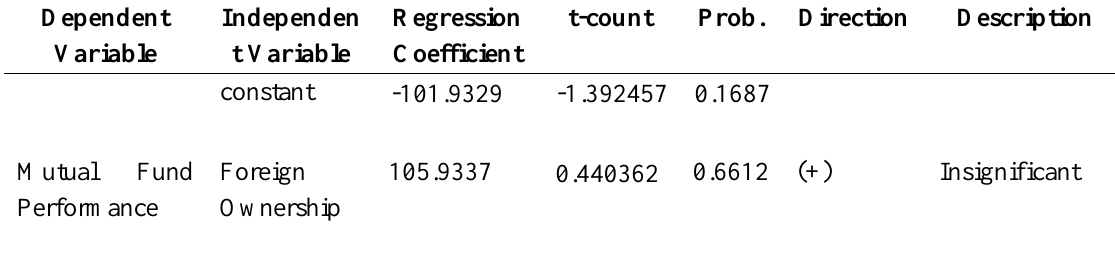
Table 3. Results of Data Panel Regression Analysis on Mutual Fund Performance (MFP) Variables, Foreign Ownership (KPAS), And Investment Ability